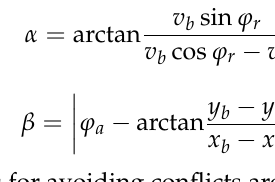
Figure 3. Schematic diagram of two-aircraft conflict detection. The radius of the protection area for each aircraft is 5 km, and two straight lines are tangent to aircraft (cid:1828) and the relative velocity vector Z b − Z a is parallel to the above two straight lines. The flight corridor in which aircraft B moves along the direction of aircraft A is also formed by the enclosed area, which is formed by the above two straight lines. α , β indicates the angle between the movement direction of aircraft A and the relative velocity vector and relative position vector. γ indicates the angle between the edge of the protection area and the line connecting the two aircraft. If part of the protection area of aircraft A overlaps the flight corridor of aircraft B , it indicates a potential conflict will occur